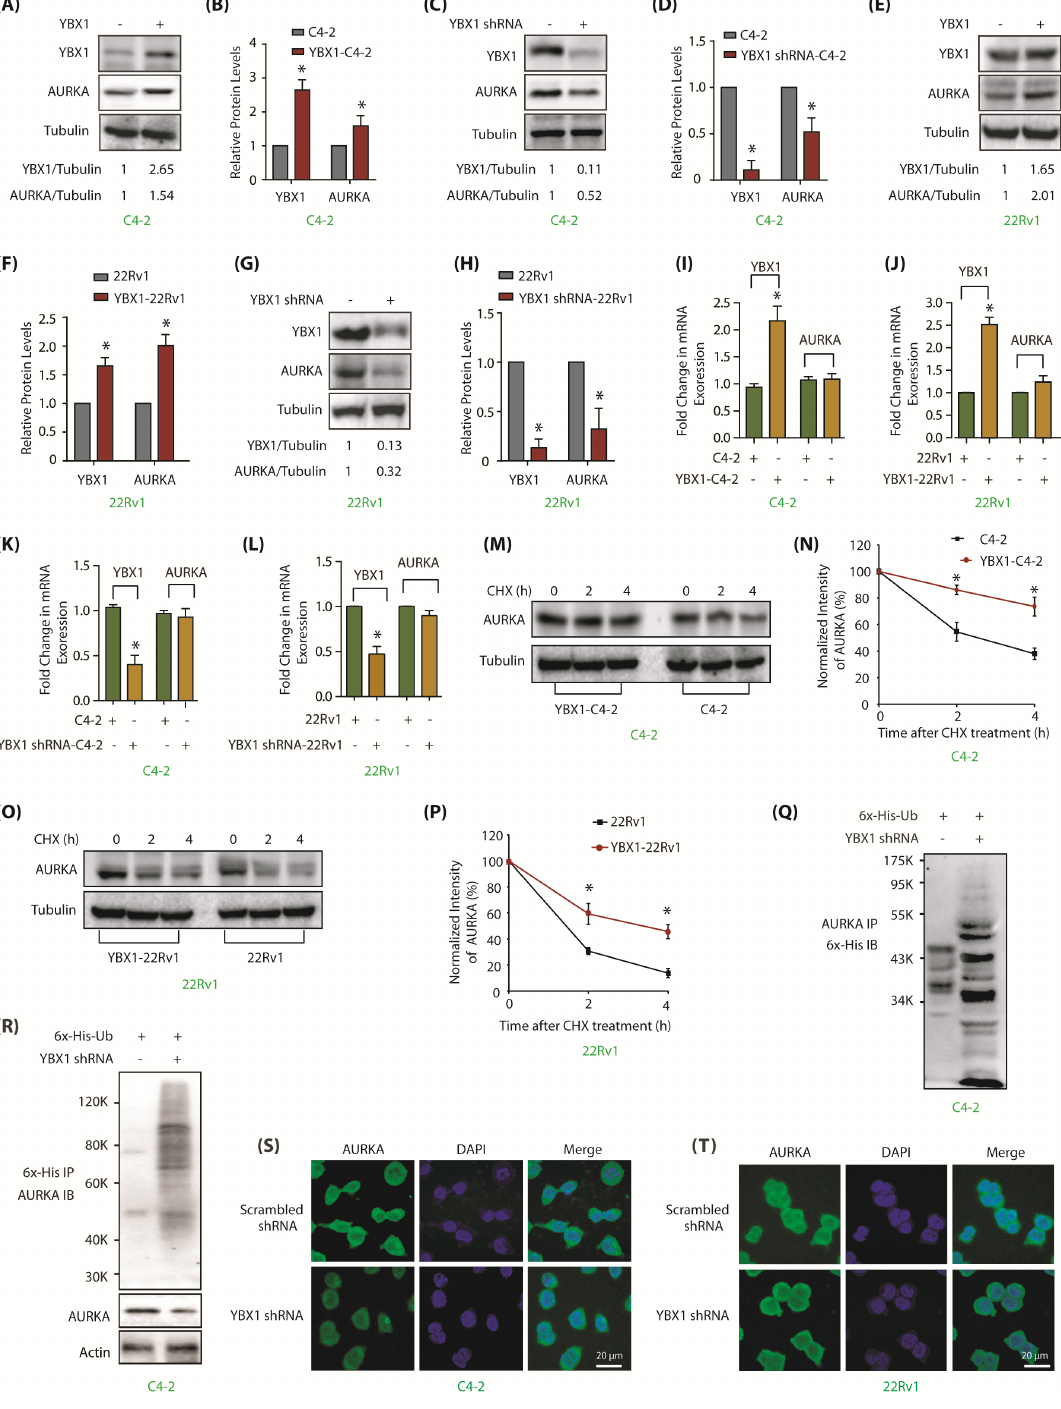
Figure 3. YBX1 stabilizes AURKA protein in C4-2 and 22Rv1 cells. ( A ) Overexpression of YBX1 enhances AURKA levels. ( B ) Histogram shows relative band intensities of YBX1 and AURKA normalized to the corresponding tubulin level from three independent experiments. * signifies significance at p < 0.05 compared to control. ( C ) YBX1 knock-down using YBX1 shRNA decreases AURKA in C4-2 cells. Cells were infected with control shRNA lentivirus (lane 1), or YBX1-shRNA lentivirus (lane 2), and AURKA and YBX1 levels were analyzed after 30 h. ( D ) Histogram shows relative band intensities of YBX1 and AURKA normalized to the corresponding tubulin level from